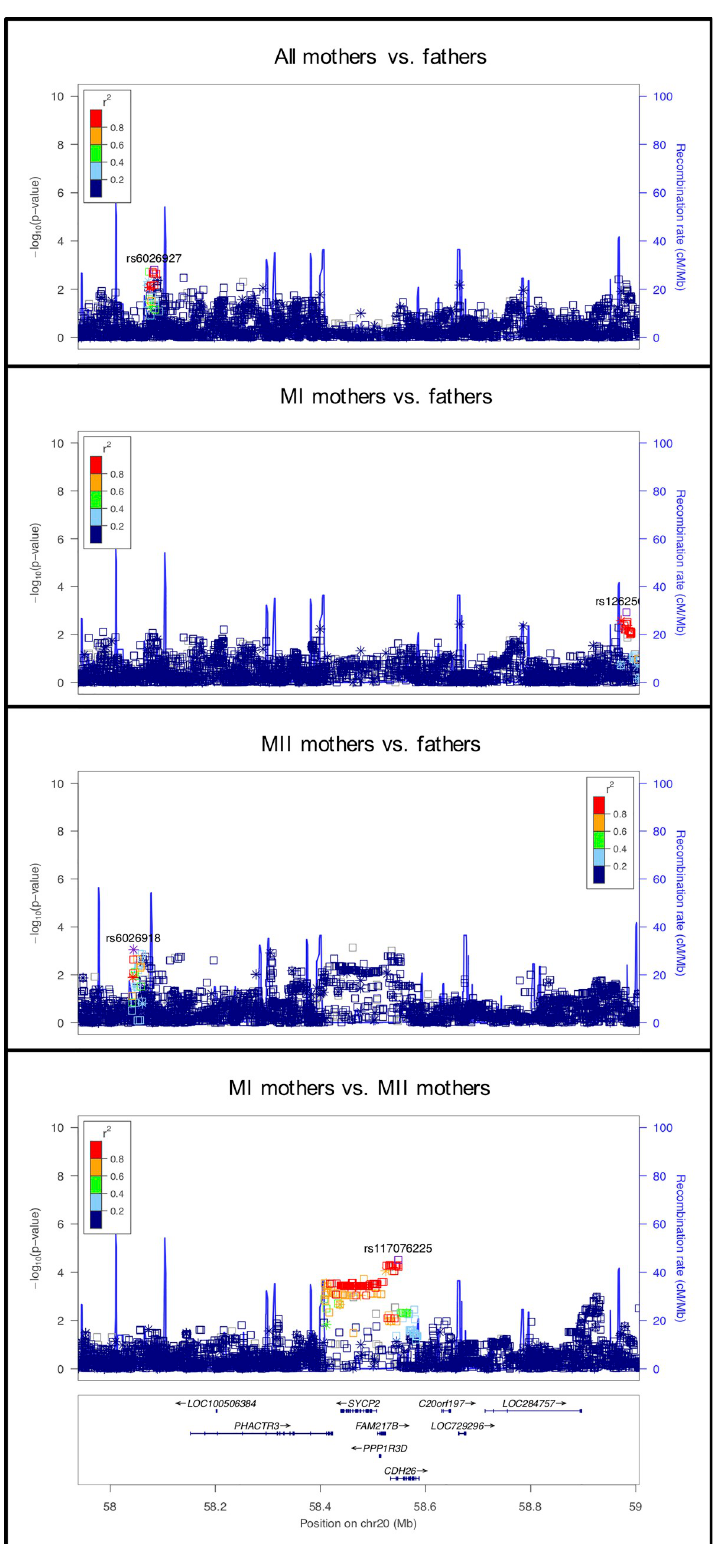
Fig 5. LocusZoom plot for SMEK1